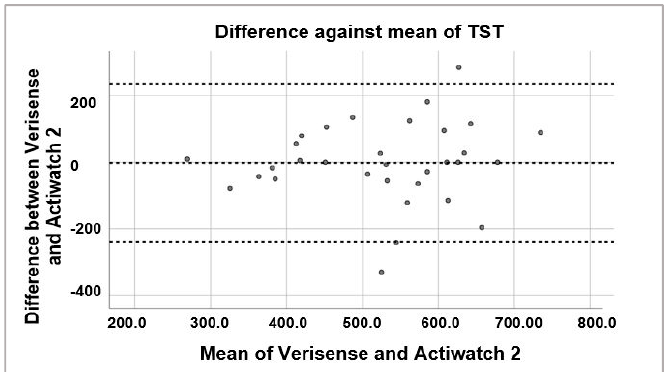
Figure 8. Bland–Altman plot of TST estimated by Verisense as compared to Actiwatch 2.